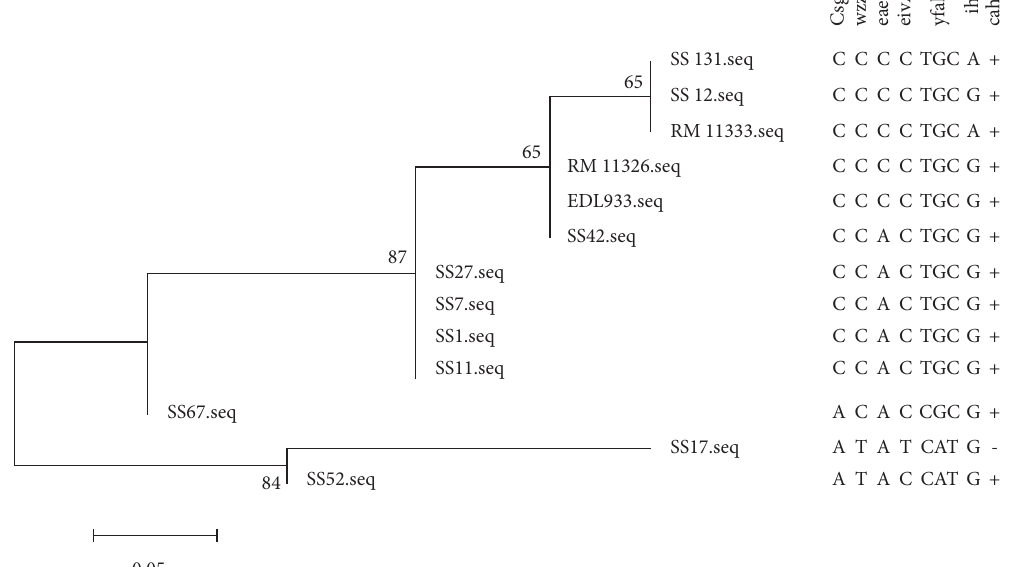
Figure 2: Phylogenetic analysis of SS isolates to EDL933 based on adhesins. A maximum likelihood bootstrap analysis was performed using the adhesion-related genes that displayed SNPs compared to the EDL933 isolate. There were 11 other isolates in combination with SS17 and EDL933 run in this analysis. This analysis revealed that, solely based on these adhesins, the isolates clustered close to their lineages and PFGE types. The panel to the right is aligned with the nucleotide changes in each gene aligned to the nucleotides found in the corresponding isolate. The scale (0.05) indicates distance based on the number of